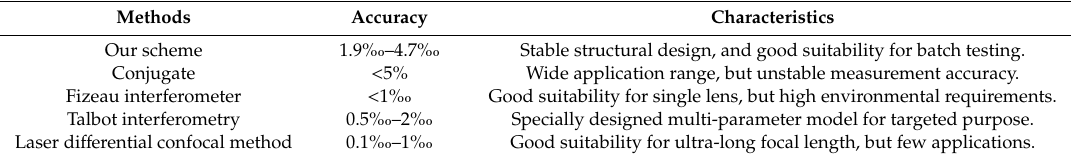
Table 3. Comparison of existing focal length measurement